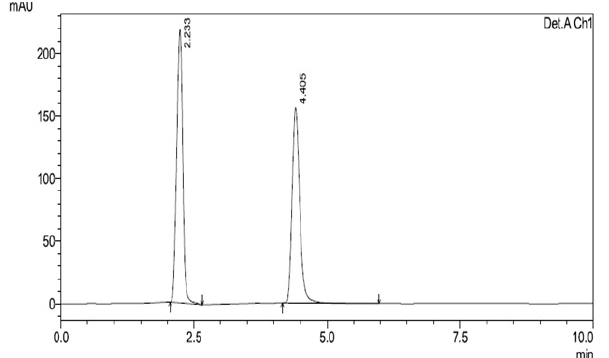
FIGURE 8 - Optimized RP-HPLC chromatogram for TOR and EPL at 223